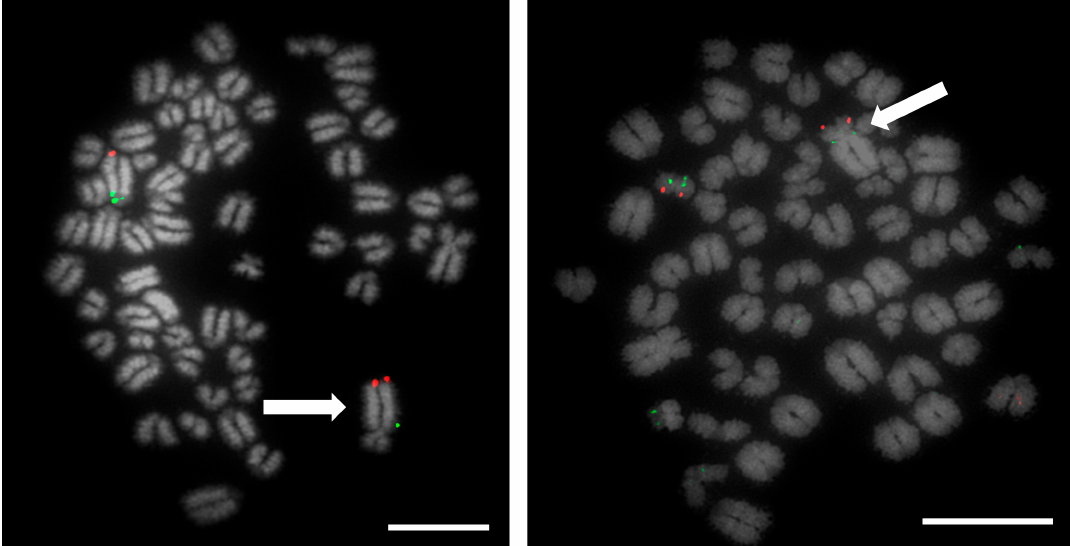
Figure 3. Metaphase spread of heterozygous 1;29 translocation carrier. Left image shows labelled FISH probes for chromosome 1, where CH240-321O2 (FITC) is the proximal probe and CH240-96M6 (TxRed) is the distal probe. The translocation is marked by an arrow. Right image shows labelled FISH probes for chromosome 29, where CH240-367D17 (FITC) represents the proximal probe and CH240-257F23 (TxRed) maps to the distal end- The translocation is marked by an arrow. Scale bar 10 µ m.